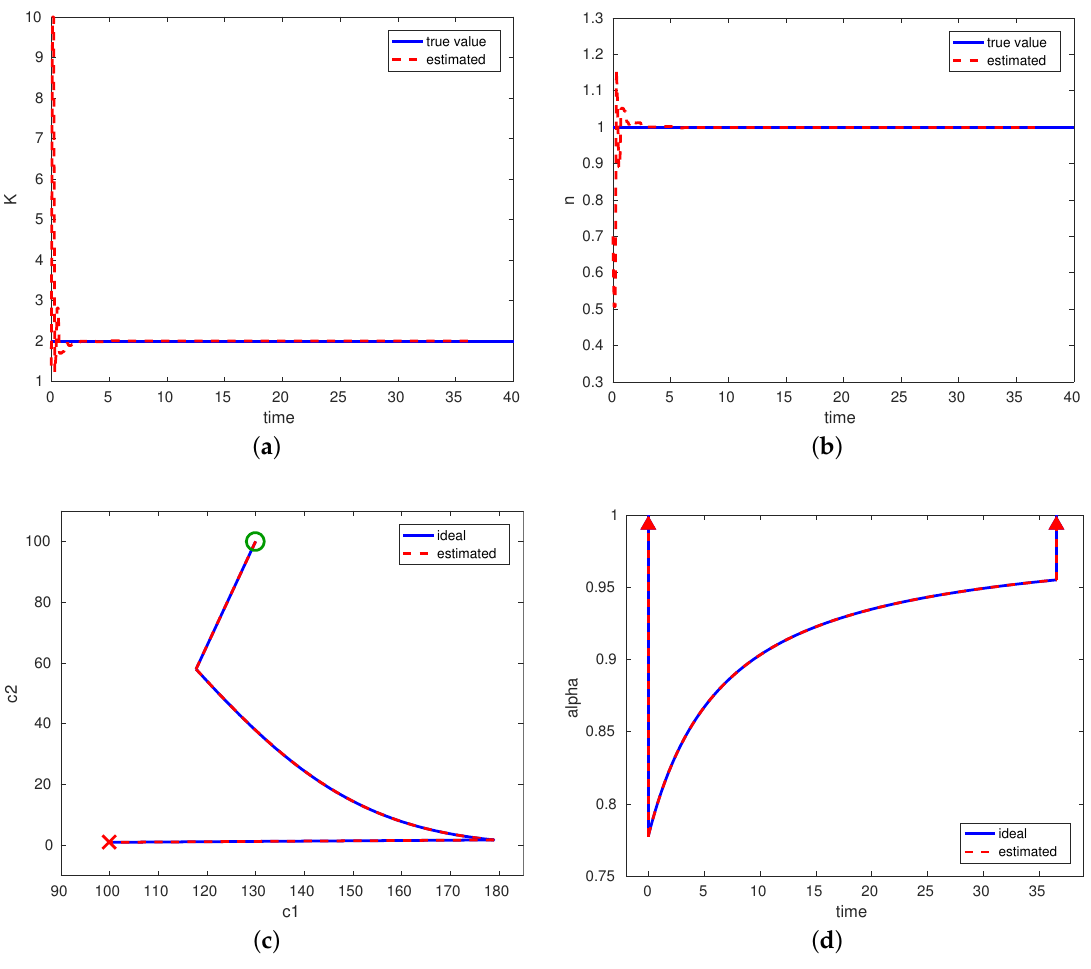
Figure 5. Estimation of fouling parameters, concentration state diagram and optimal control profile for ideal and estimated fouling parameters ( K = 2 and n = 1) using the WLS estimation method. ( a ) Estimation of the fouling parameter K ; ( b ) estimation of the fouling parameter n ; ( c ) Concentration state diagram; ( d ) optimal control